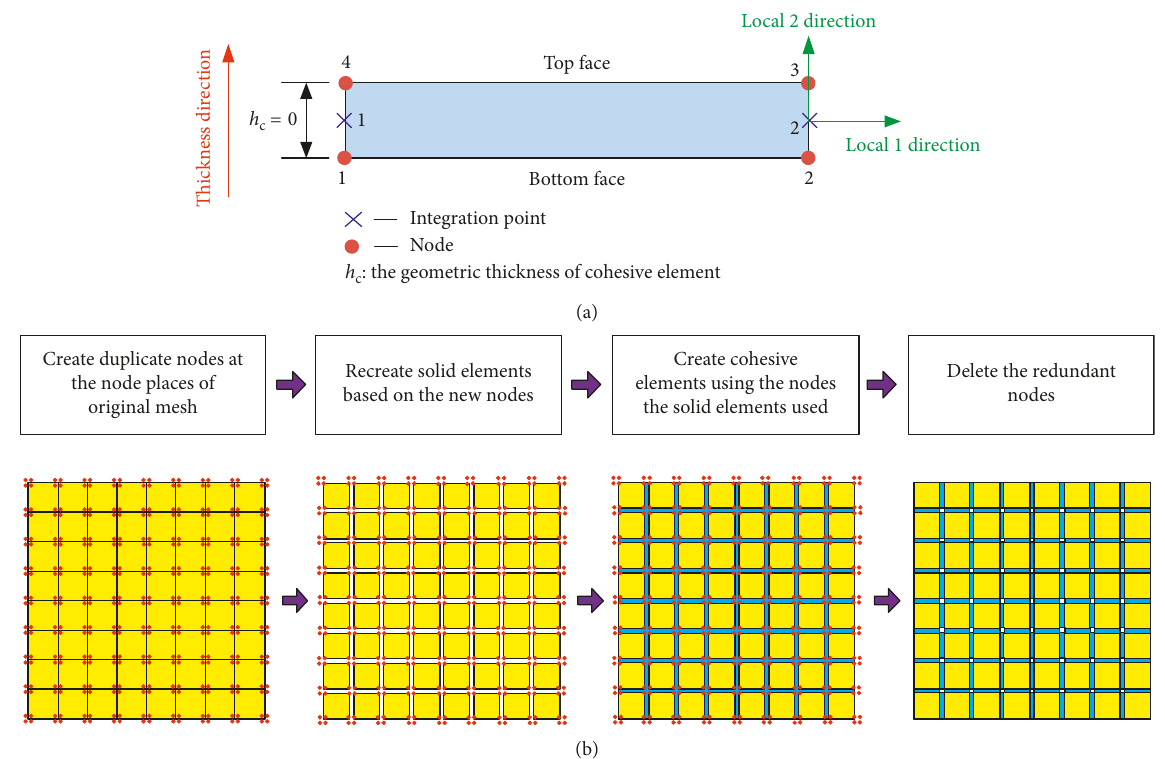
Figure 3: (a) Schematic of zero-thickness cohesive element. (b) Process of generating zero-thickness cohesive elements at every solid element